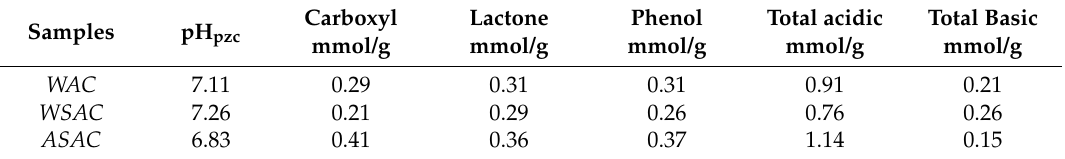
Table 3. The pH pzc and Boehm titration results of the WAC, WSAC, and ASAC samples